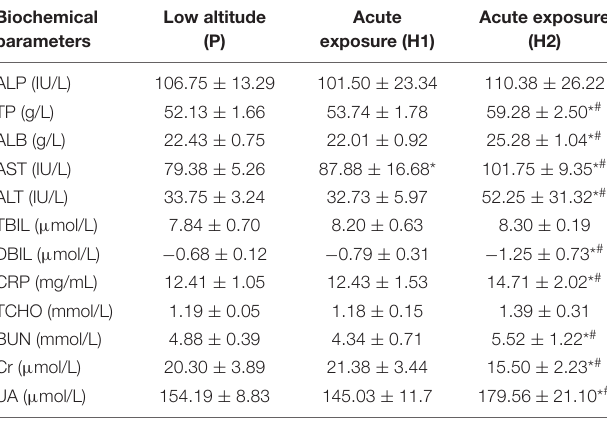
TABLE 3 | The comparison of main biochemical parameters between the three groups (mean ± SD, n = 8). Biochemical